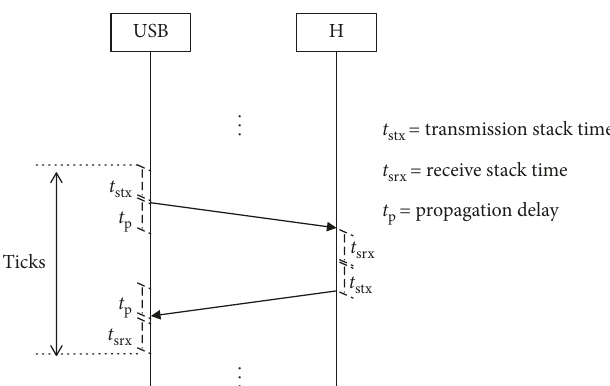
Figure 1: Test communication diagram.